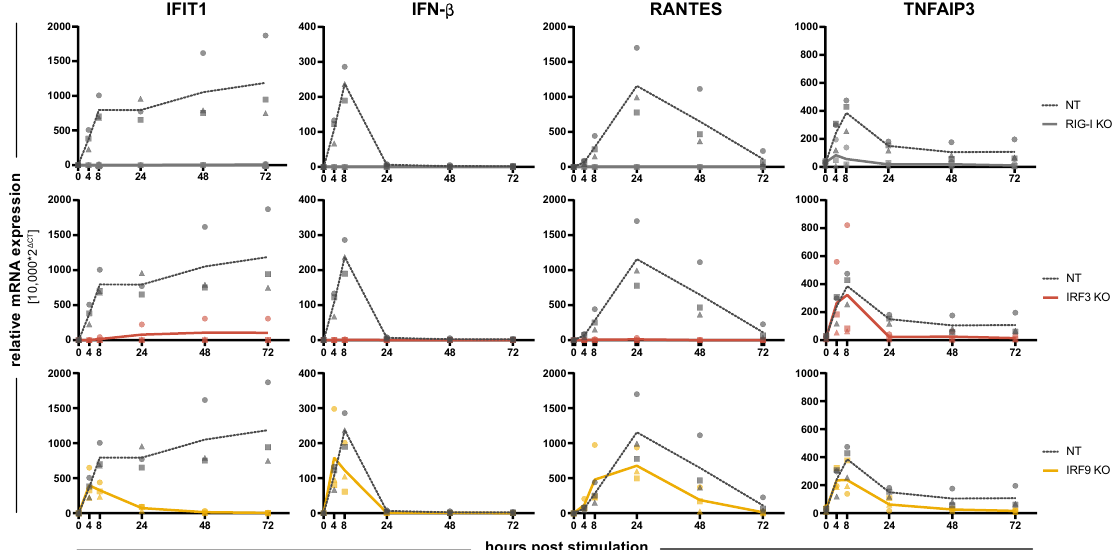
Figure 3. Impact of IRF KO on the induction kinetics of response gene expression. A549 NT , A549 RIG-I KO , A549 IRF3 KO , and A549 IRF9 KO cells were stimulated by transfection of 5’ppp-dsRNA (1 ng/well) and relative IFIT1, IFN- β , RANTES (CCL5), and TNFAIP3 mRNA levels were measured at 4, 8, 24, 48, and 72 h post stimulation (h.p.i.) by qRT-PCR. Measurements (mean of technical triplicates) of three independent experiments are shown as symbols; means of the three experiments are connected by lines to visualize the time